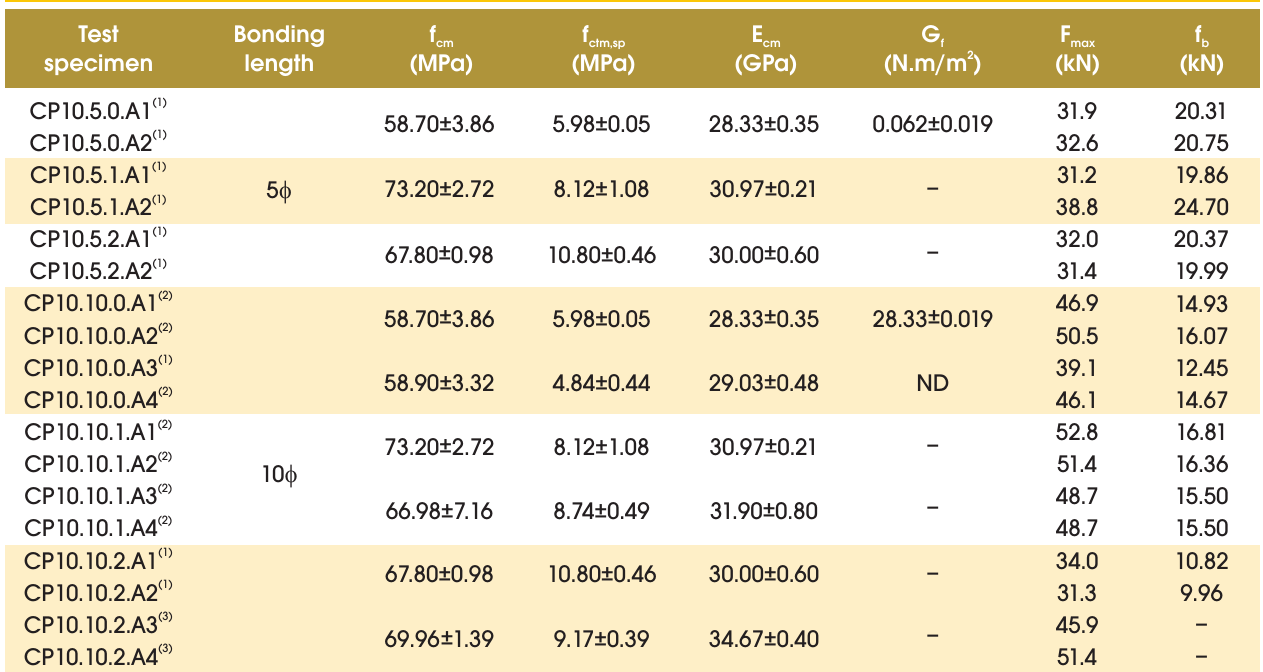
Table 3 – Results of concrete properties and pull-out test